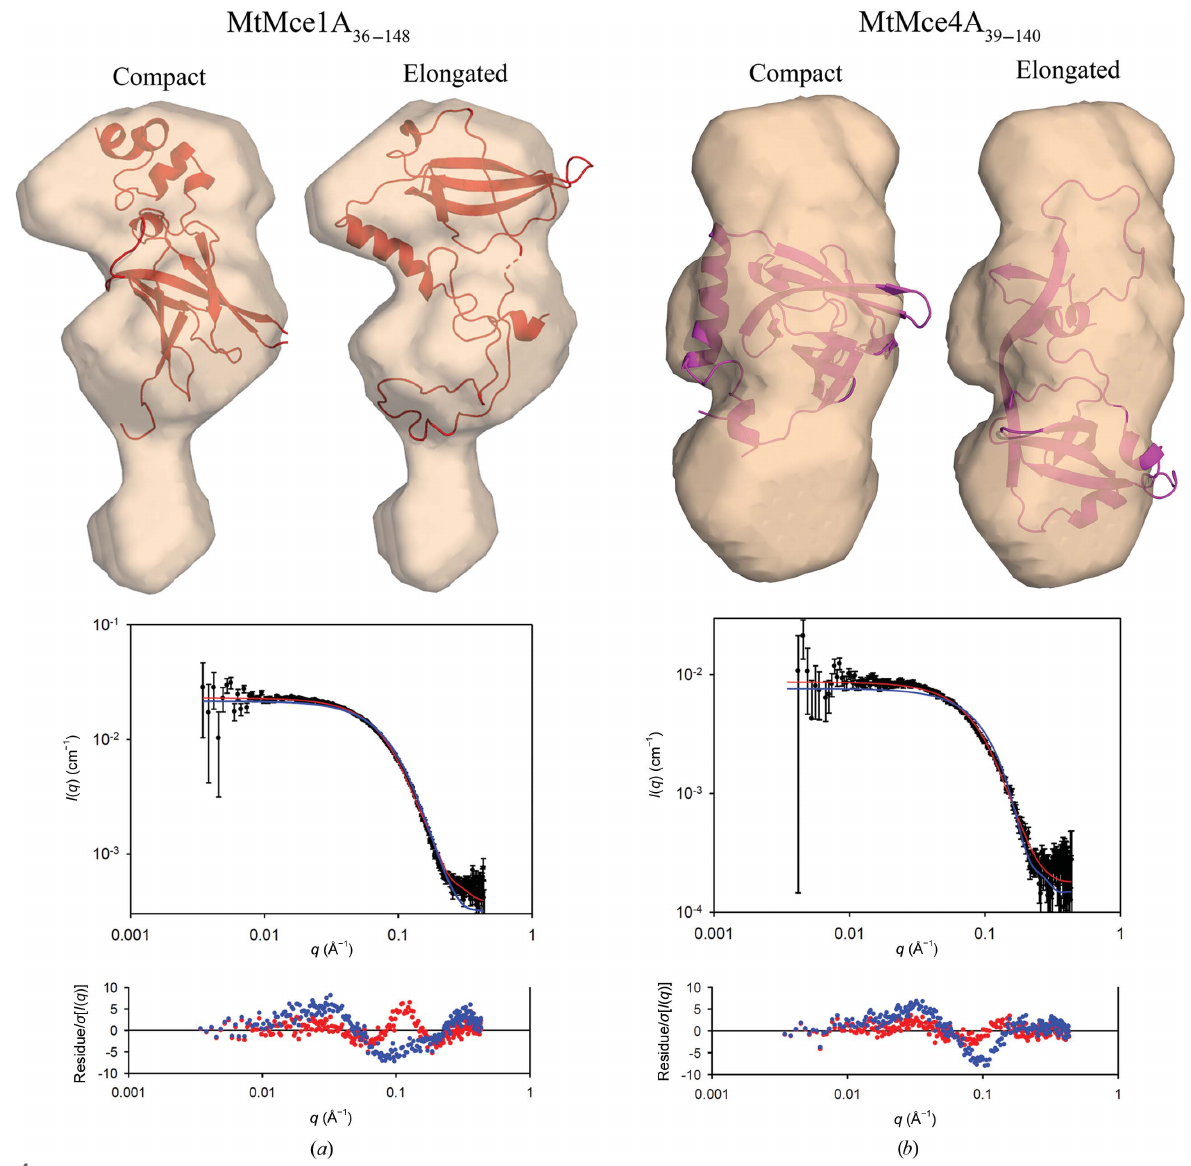
Figure 4 ( a ) The ab initio shape generated by DAMMIN for MtMce1A 36–148 superposed on the compact (left) and elongated (right) monomeric models